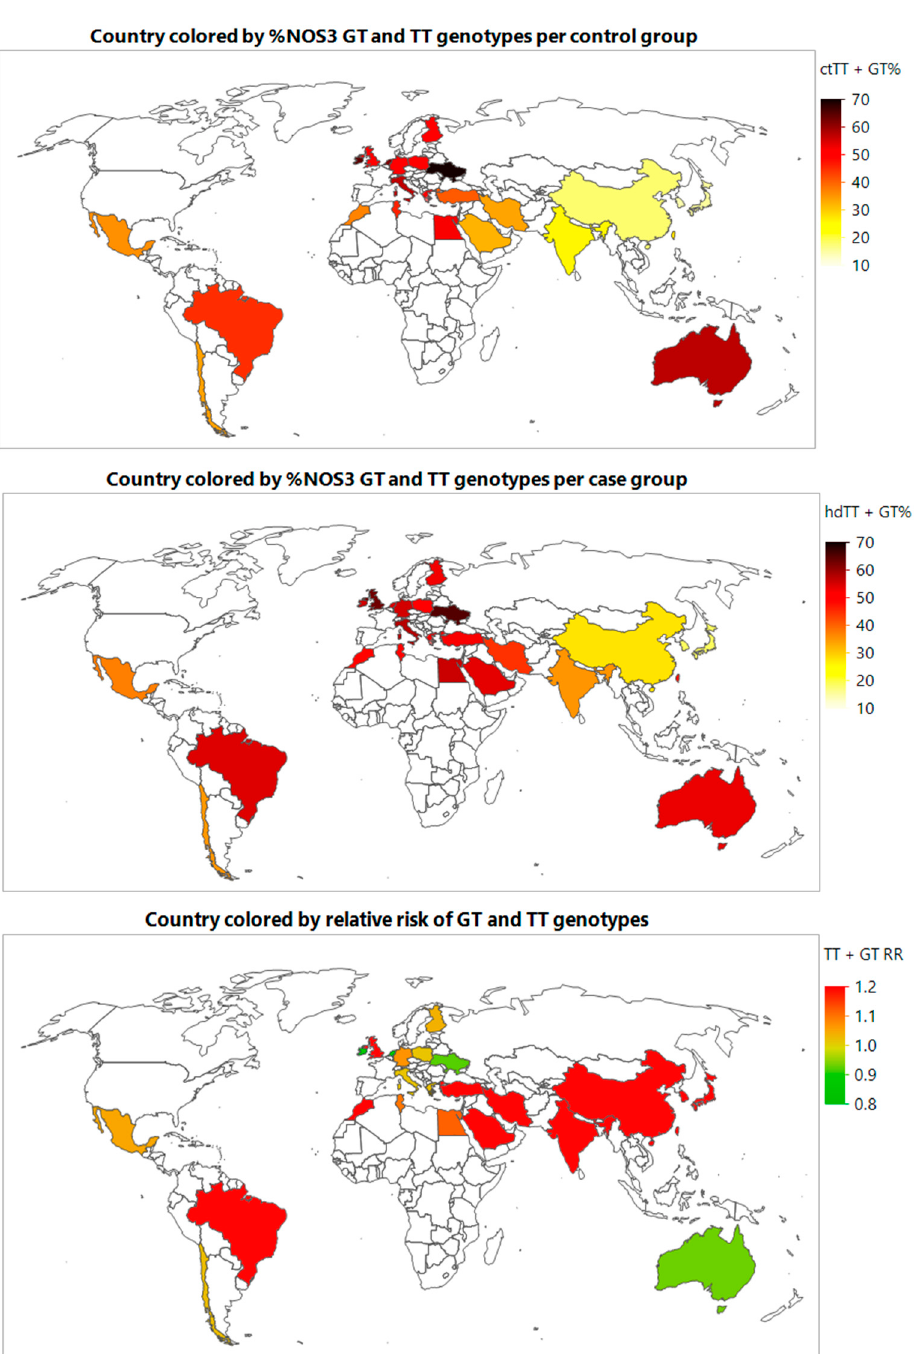
Figure 3. Geographical information map for % NOS3 GT and TT genotypes per control and ischemic heart disease (IHD) groups, and IHD risk.